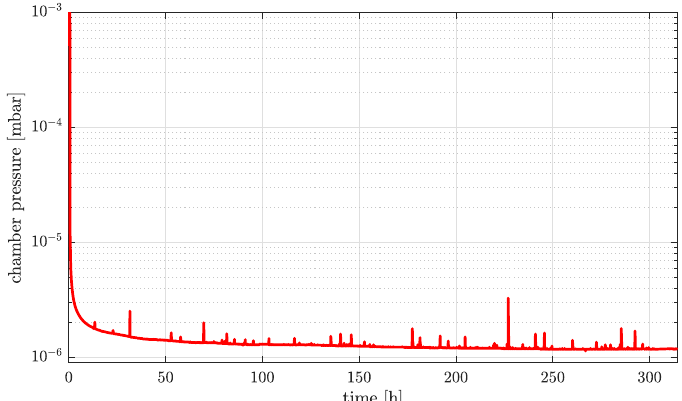
Figure 7. Pumpdown curve of the fully assembled